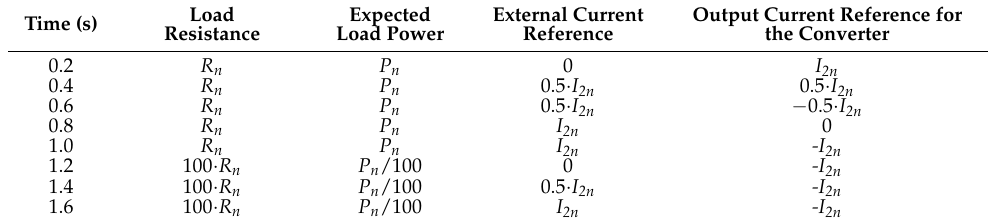
Figure 7. Performance obtained in scenario #4 (SC − GD): ( a ) actual and reference output current; ( b ) load current; ( c ) droop-controlled generator’s current and external generator’s current; ( d ) grid voltage overshoot. Table 5. Transitions considered in scenario #4